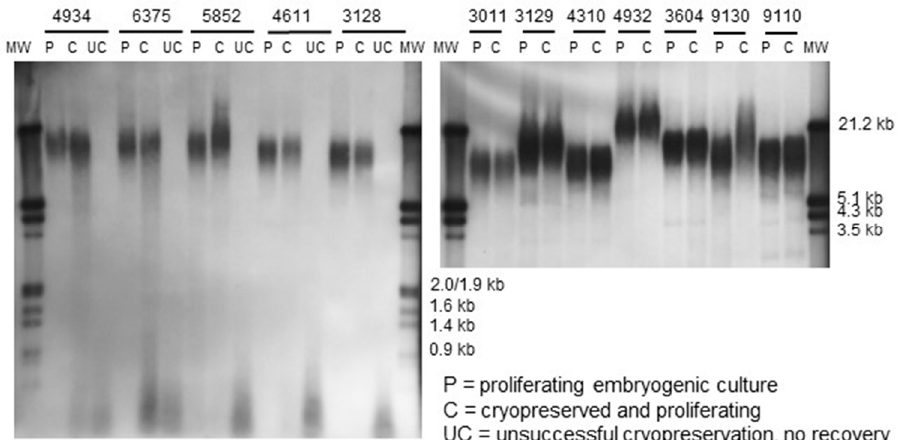
Figure 4. Southern hybridization showing telomere length in proliferating embryogenic tissue of Norway spruce prior to and following cryopreservation: The five genotypes shown on the left panel were cryopreserved both using a method leading to successful regeneration (pretreatment on semisolid media with increasing sucrose concentration, PGD cryoprotectant mixture, and slow cooling in programmable freezer) and by methods resulting in no regeneration (pretreatment in liquid medium and Me2SO as cryoprotectant, or freezing in Mr. Frosty containers at − 80 ◦ C), while the seven genotypes shown on the right panel were cryopreserved only using successful method.